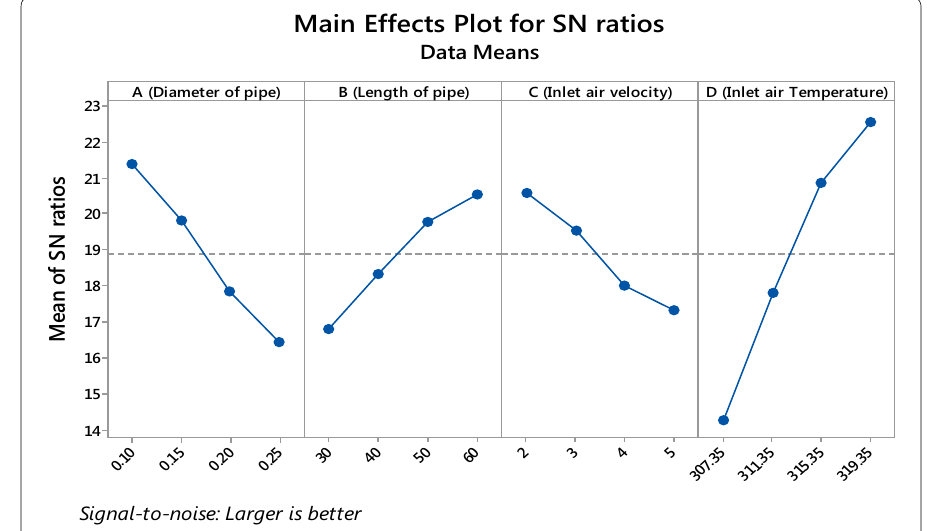
Fig. 5 Effects of design and process parameters on air temperature drop (SNR data)